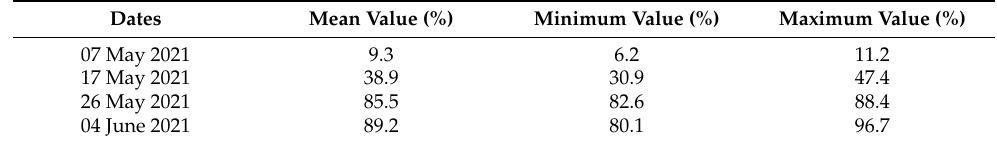
Table 3. CC (%) field measurements.